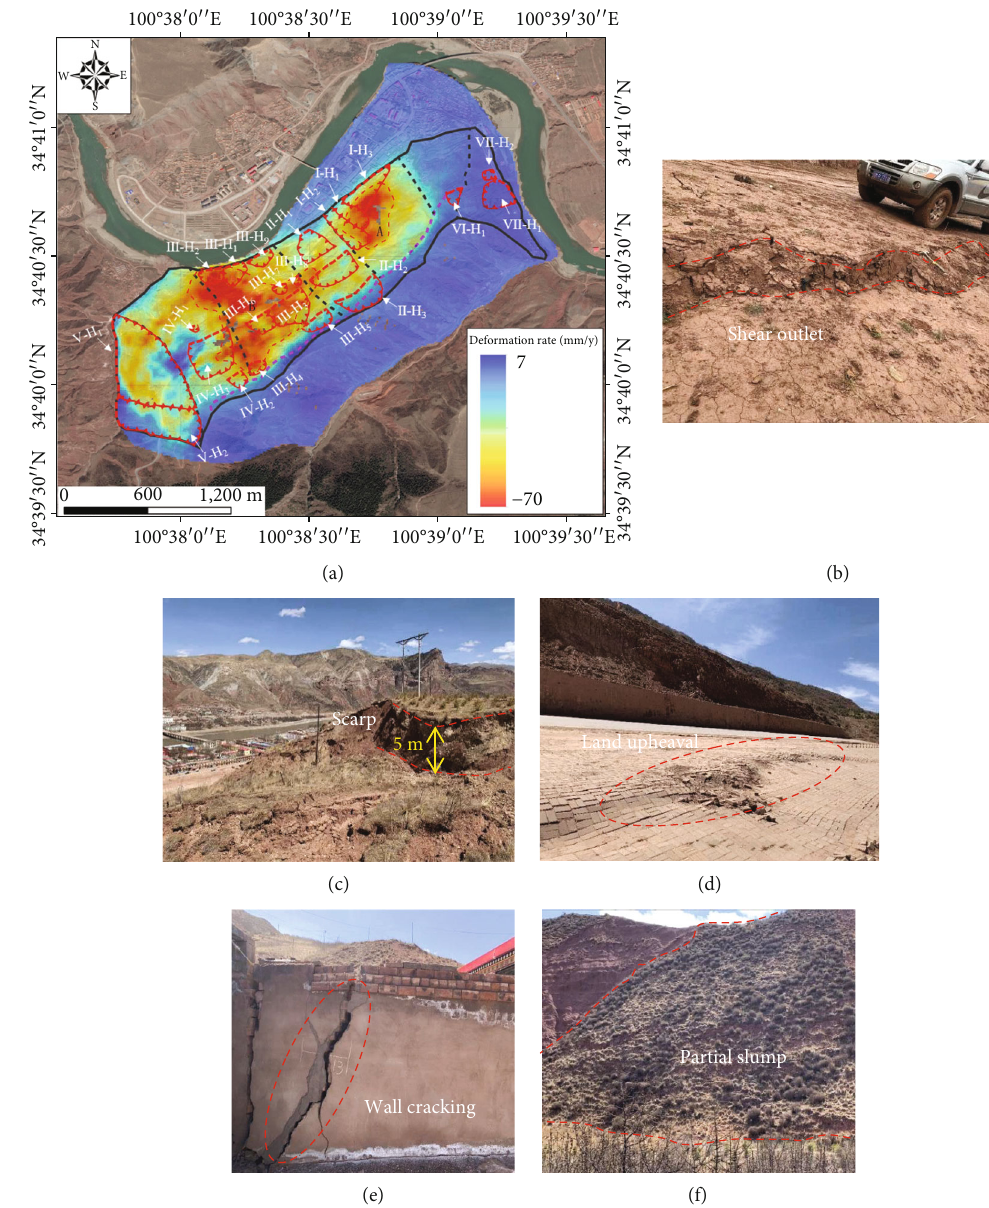
Figure 13: (a) Comparison and veri fi cation diagram of InSAR interpretation and fi eld survey. (b) Front shear outlet. (c) Front steep wall. (d) Ground uplift of the viewing platform. (e) Building deformation. (f) Partial